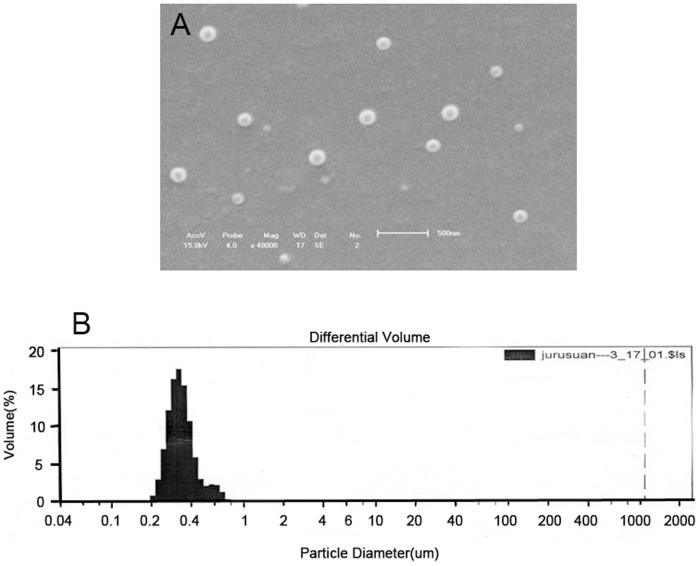
Analyze the morphology of 5-FU-NPs.(a) SEM scan showed the NPs with spherical shape and smooth surface. (b) Nanoparticle size was analyzed by laser size analysator. Results showed average-diameter of NPs is about 310 nm. Distribution of nanoparticles was range from 255 nm to 469 nm and 70% were less than 385 nm. P<0.05.